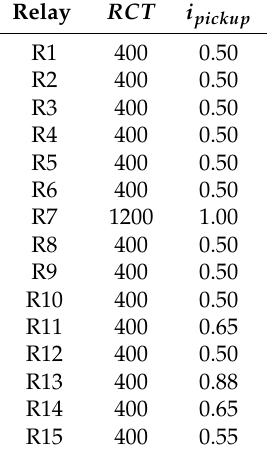
Table 2. RCT and i pickup for each relay.